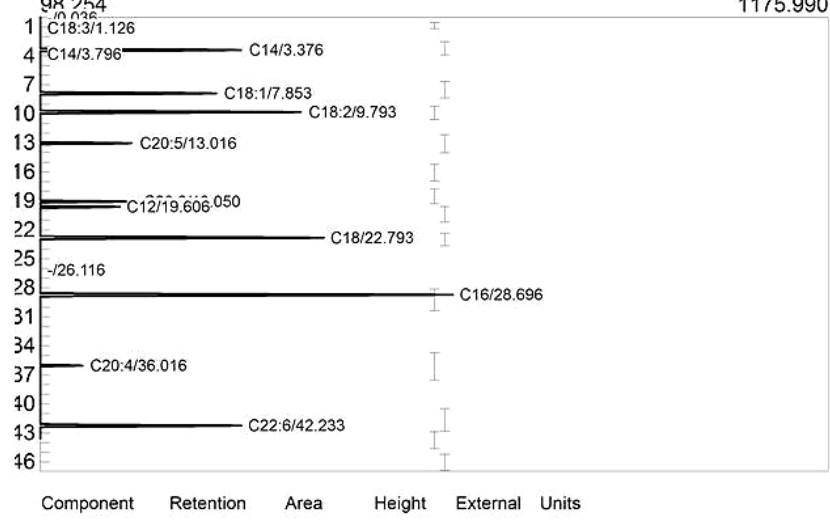
Figure 2. GC-FID spectrum of the bio